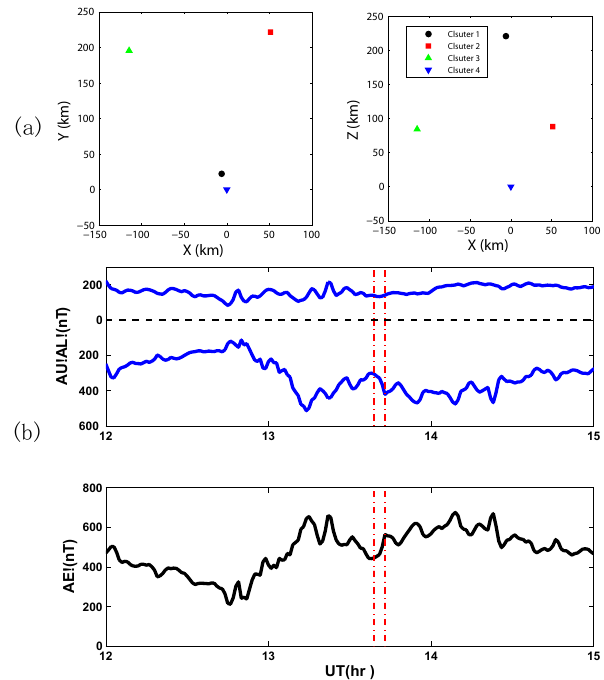
Fig. 1. (a) The relative positions of the four Cluster spacecraft at 13:39UT on 29 August 2003 are presented in the GSM coordinate. Cluster-4 was located at ( − 17.48, − 1.77, 2.87) R E . (b) AU, AL and AE index from 12:00 to 15:00UT on 29 August 2003. The red dashed vertical lines mark the time interval of